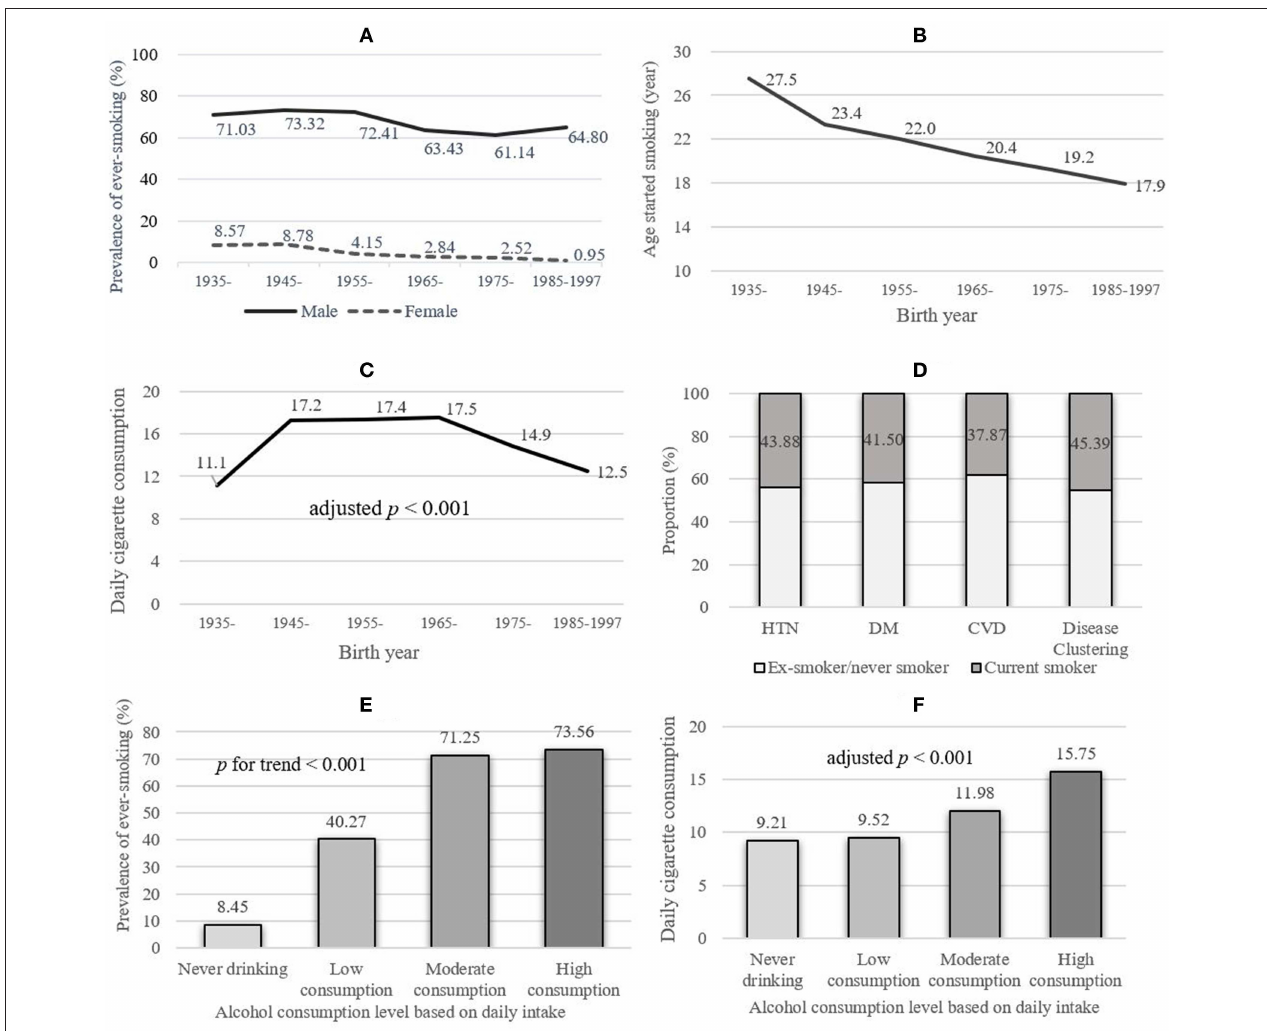
FIGURE 1 | The smoking prevalence and patterns among participants aged 20–80 in Hebei Province, central China, 2017. HTN, hypertension; DM, diabetes; CVD, cardiovascular disease; disease clustering: having more than one disease of HTN, DM, or CVD. Alcohol consumption categories: low ( < 40 g/day), moderate (41–60 g/day), and high ( > 60 g/day). Cochran–Armitage test was used to perform trend test. (A) Sex- and age-specific prevalence of ever-smoking. (B) The education-adjusted regular smoking started age among male ever-smokers, stratified by different birth year groups. (C) Daily cigarette consumption of male ever-smokers, stratified by different birth year groups. (D) The prevalence of current smoking among male participants with diagnosed chronic diseases. (E) The prevalence of ever-smoking stratified by alcohol consumption levels. (F) Age- and education-adjusted daily cigarette consumption of male ever-smokers, stratified by alcohol